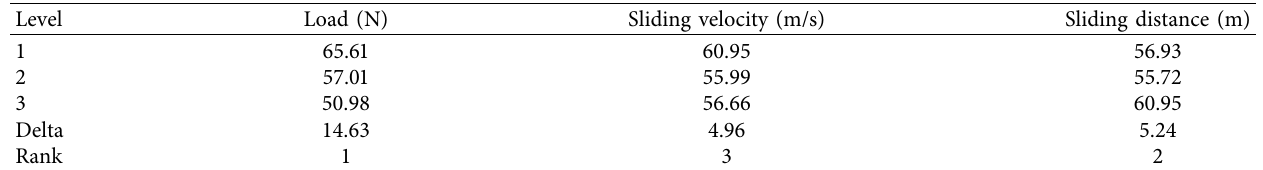
Figure 7: Main effects’ plot for the S-N ratio of CoF. Table 3: S/N ratio value of wear